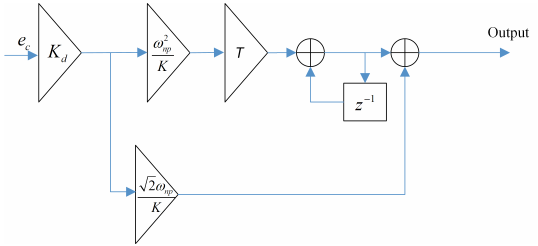
Figure 10. Structure diagram of digital loop filter of